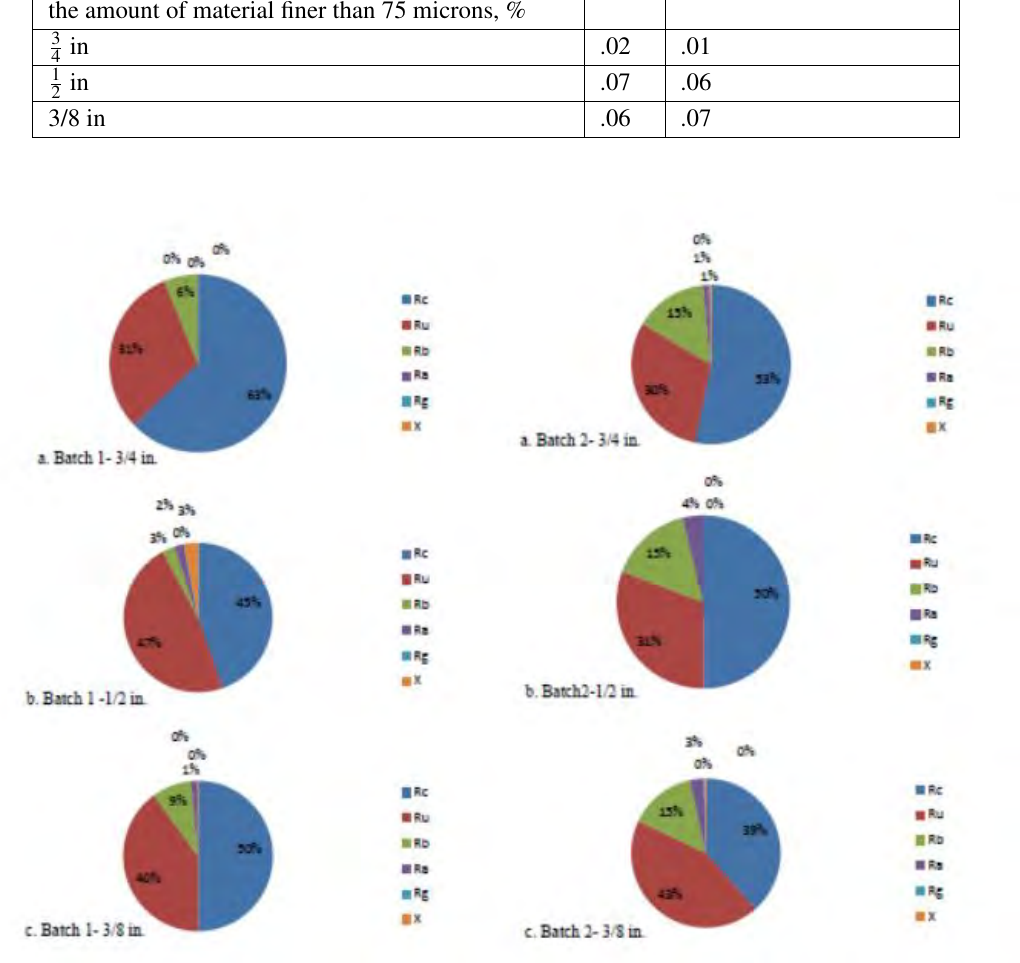
Figure 3. The proportions of constituent materials ofrecycled